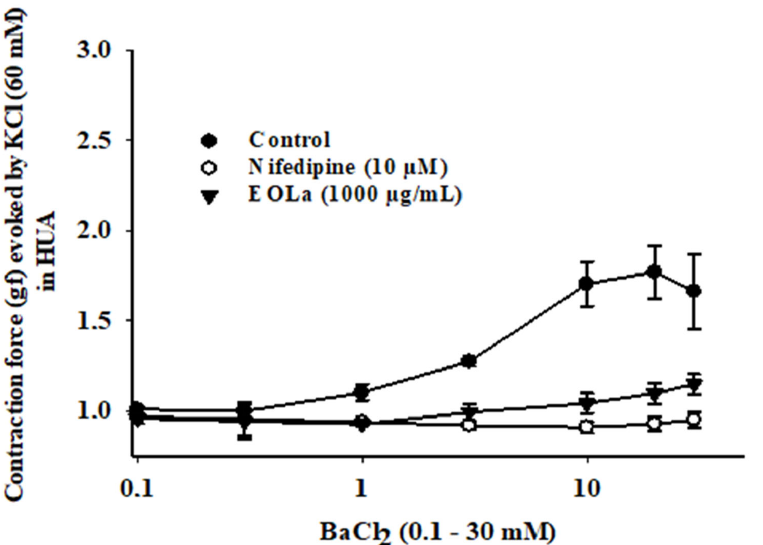
Table 1. Contraction agonists and blocking agents (substances); concentration values capable of triggering 50% of relaxing response (EC 50 ); values of statistically significant initial concentrations (SSIC) and total relaxation (%) promoted by the Lippia alba essential oil in the presence of differing contractile agents and channel blockers. Substances EC 50 of EOLa SSIC, Total Relaxation (%) Potassium chloride (60 mM) 377.0 ± 4.3 μ g/mL 100 μ g/mL ( p < 0.017), 100% Serotonin (10 μ M) 339.8 ± 4.5 μ g/mL 200 μ g/mL ( p < 0.001), 100% Histamine (10 μ M) 277.1 ± 8.5 μ g/mL 200 μ g/mL ( p < 0.001), 100% Tetraethylammonium (1 mM) 471.2 ± 5.8 μ g/mL 200 μ g/mL ( p < 0.023), 100% 526.4 ± 4.0 μ g/mL